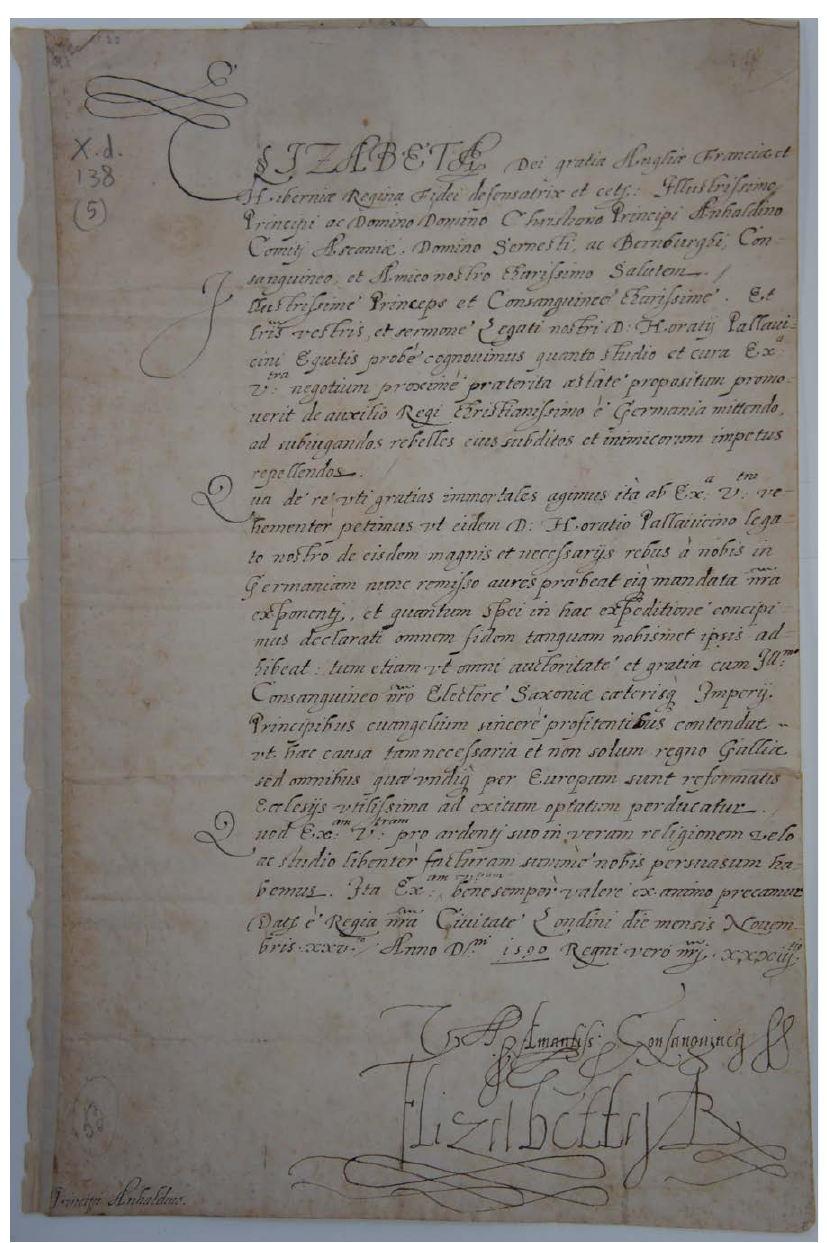
Fig. 2a – Latin letter penned by scribe ‘B’ and signed by Elizabeth with the addition of the signet seal, 1590 (reproduced by permission of the Folger Shakespeare Library,